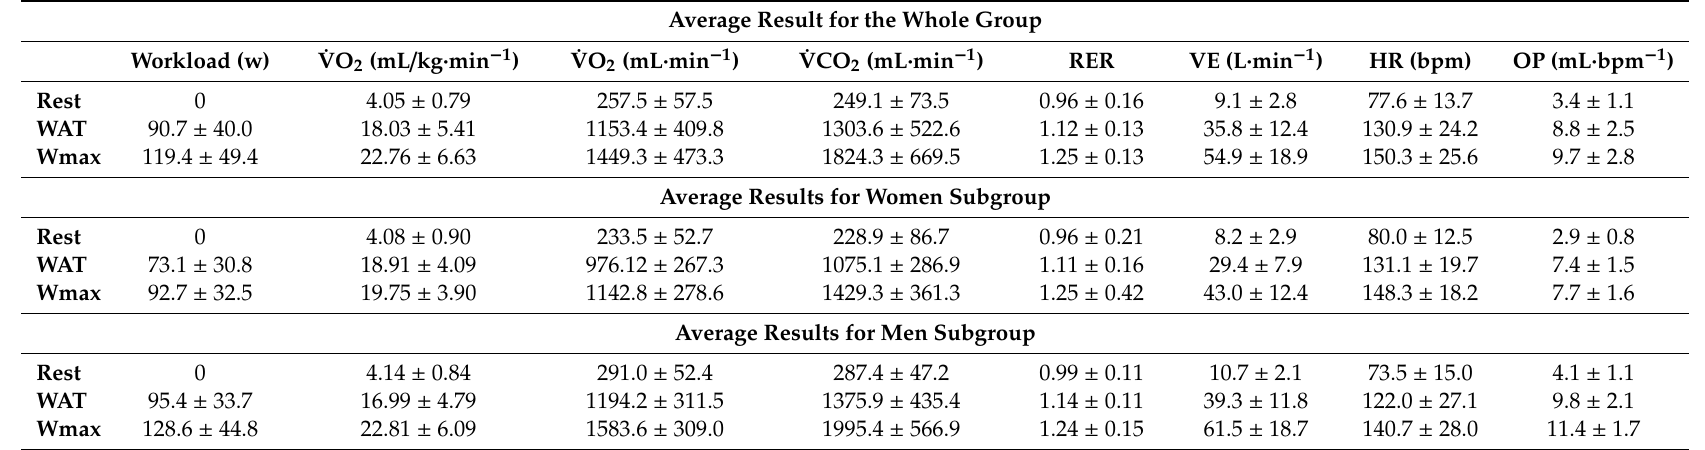
Table 2. Results of the cardiopulmonary test (CPX) test for the whole group (top table), and for women (middle table) and men subgroups (bottom panel). Average Result for the Whole